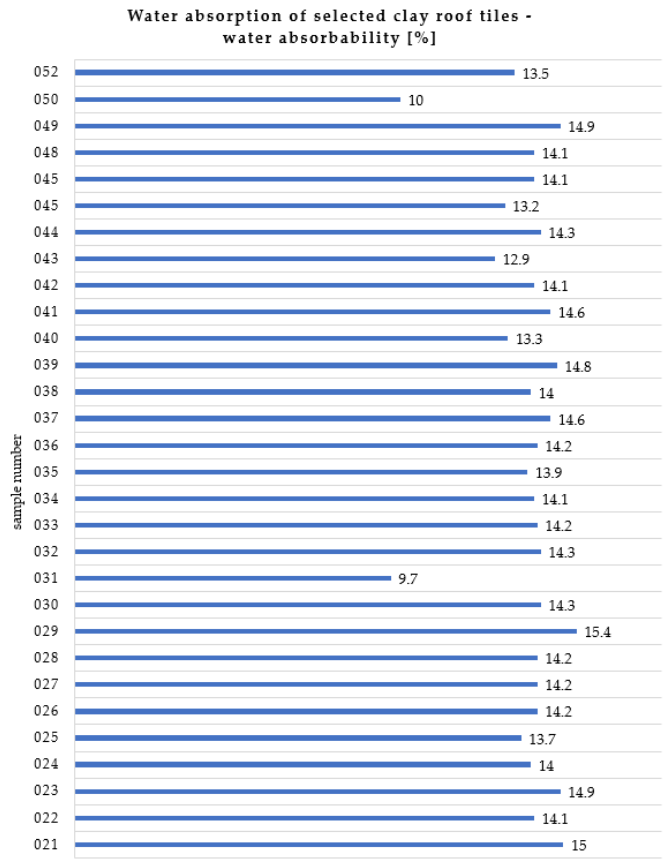
Figure 6. Water absorption of selected historical clay roof tiles.